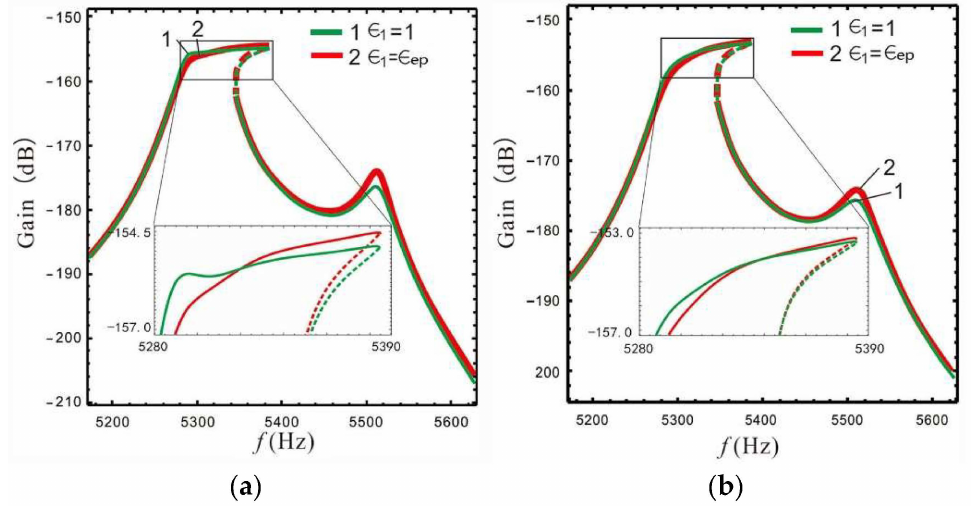
Figure 15. Gain is affected by FCP: ( a ) B = 2.4, ( b ) B =